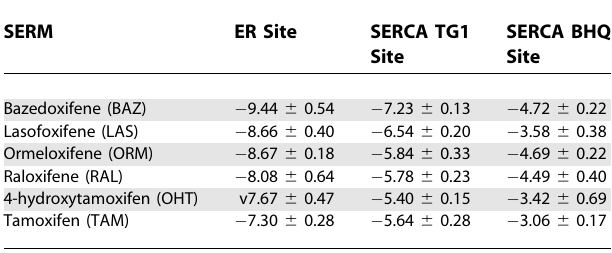
Table 1. Docking Scores (Unit of log( K d)) for the SERM Binding Site to ER a and Predicated Off-Target Binding Sites of SERCA